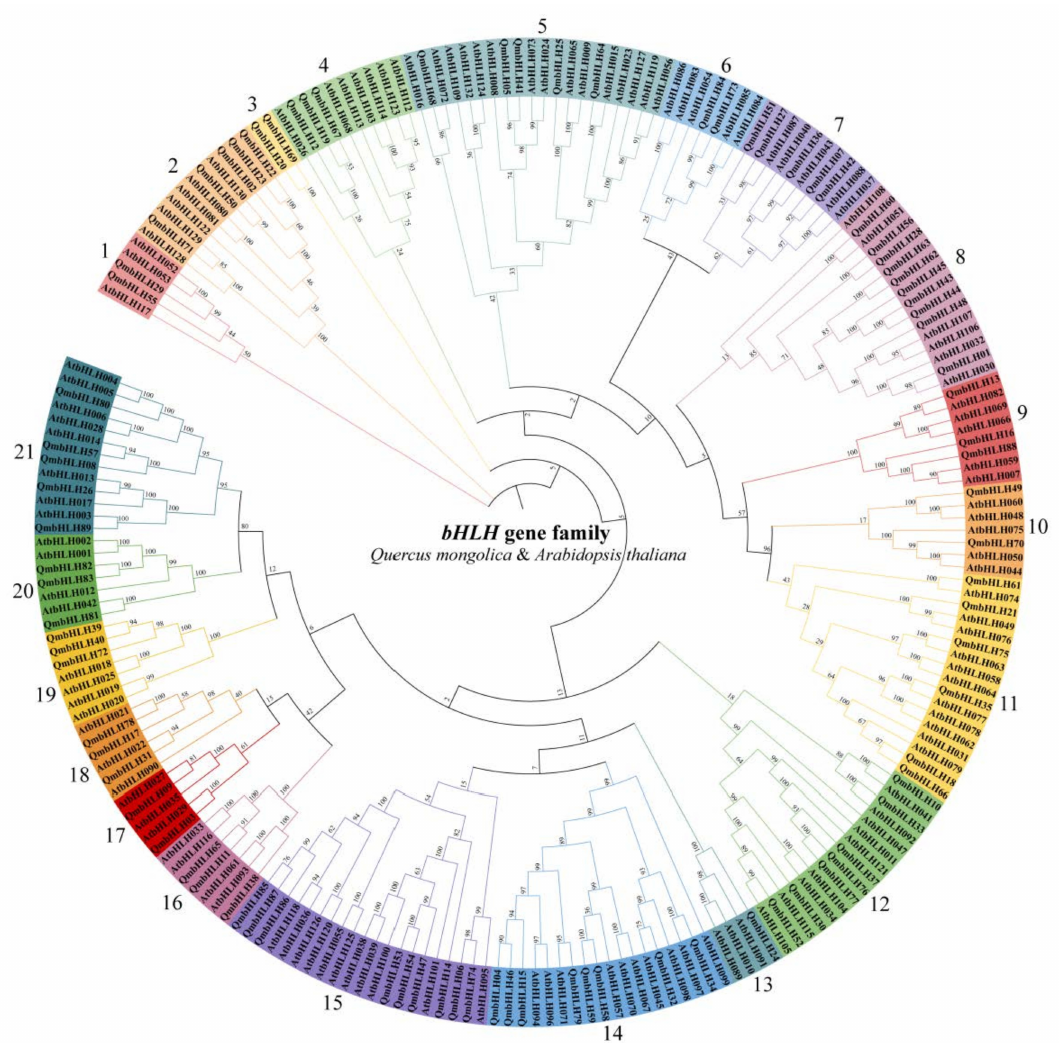
Figure 1. Phylogenetic relationships among the bHLH proteins in Q. mongolica and A. thaliana . The phylogenetic tree was built in MEGA 7.0 via the N-J approach with 1000 bootstrap replicates. All QmbHLH genes were grouped into 21 subgroups according to the topological structure of the tree and classification rules of the Arabidopsis bHLH